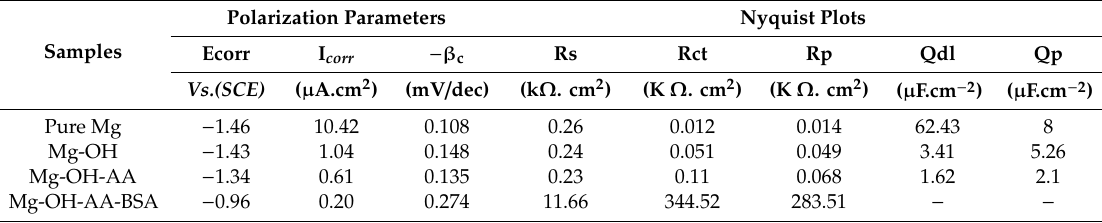
Table 1. The value of electrochemical parameters obtained from various samples using potentiodynamic polarization technique (calculated from Tafel plots and Nyquist plot), measured in SBF solution at 37 ◦